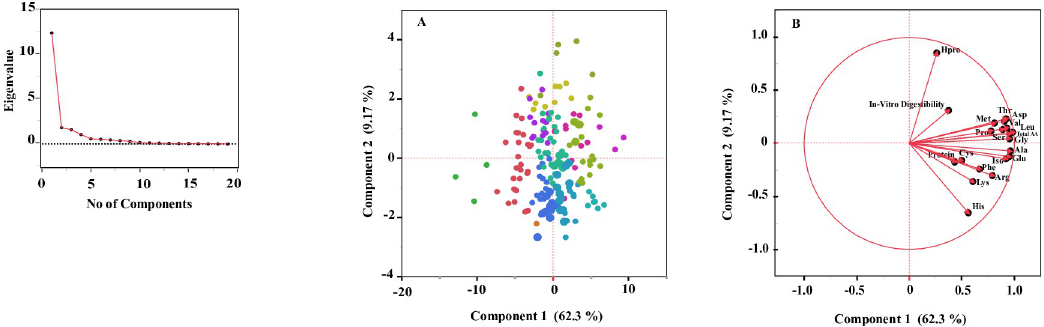
Fig 1. Principal components of individual amino acids (g/100 g), total amino acids (g/100 g), protein (g/100 g), and in vitro digestibility of organic dry pea: (A) scatter plots and (B) biplots of components 1 and 2.